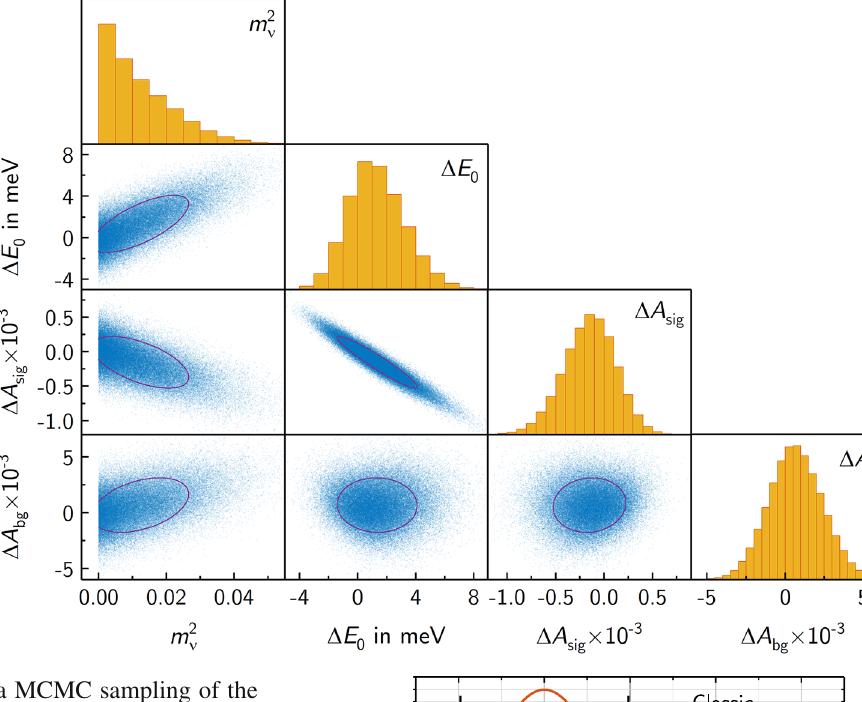
Fig. 16 Scatter plots for pair-wise parameter combinations ( m 2 ν , E 0 , A sig , A bg ) and their respective marginalized posterior distributions as the diagonal elements for 3 years of live measurement time. The solid contours indicate 95%C.L. regions. Instead of randomized data, the likelihood sampled in this MCMC example was formulated based on a null hypothesis with fiducial input values m 2 ν = 0 eV 2 , E 0 = 18 , 575 eV, A sig = 1 . 0,